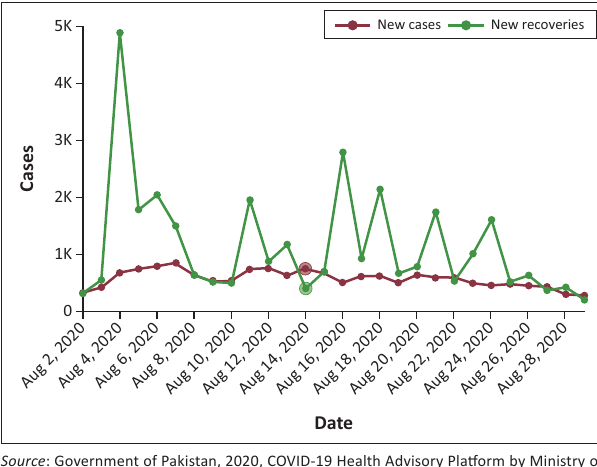
FIGURE 3 : Graphical representation of ratio of new COVID-19 cases versus the rate of recovering